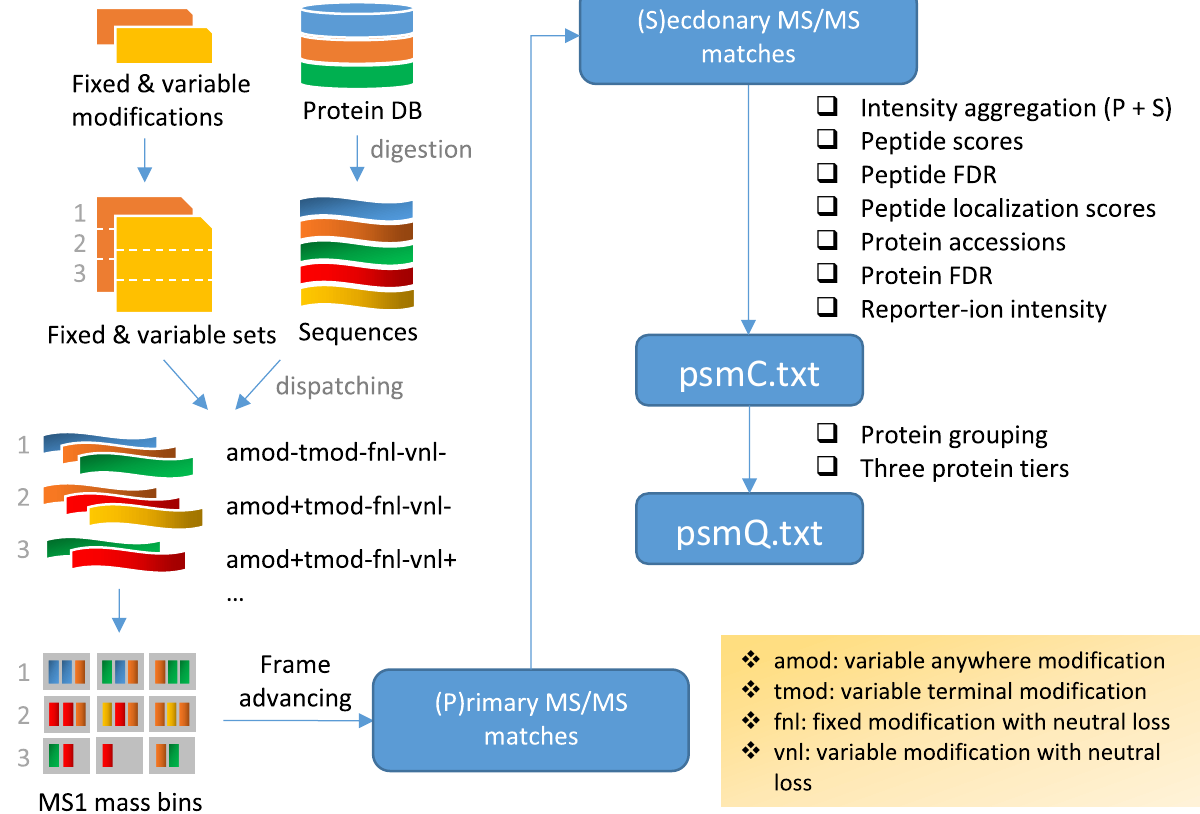
Figure 1. The Mzion workflow. User-supplied fixed and variable modifications are compiled into sets of fixed and variable modifications (Supplementary Note 1). The peptide candidates from in silico digestion are dispatched according to the modification sets (Supplementary Fig. 10). For instance, only sequences with amino-acid residue M will be retained if methionine oxidation is part of the variable modifications in a given set. The sequences are then binned by their precursor masses and searched against experimental MS data. The MS/MS features are first matched by primary product ions, for example, b - and y -ions. The secondary ions, b *, y * (–NH3) etc., are then searched for and the signals are ascribed to the corresponding primary ions. The, and only the, primary ions with the boosted intensity are used in peptide Table 1), the compilation and minimization by Mzion leads to a total of twelve combinations of fixed and vari- able modifications (Supplementary Table 2). It has been observed that an enlarged search space can reduce the numbers of identified PSMs and peptides when controlling false discovery rates (FDR) 19 . The combinatorial minimization by Mzion guards against undue expansion of a search space with regard to users’ intention in finding peptides that are more likely to present in samples. In an example of acetylome (Supplementary Table 3: dataset Lung_A), the numbers of PSMs, peptides (without modifications) and sequences (with applicable modifications) increase by 6.2%, 5.2% and 7.3%, respec- tively, upon the refinement of search space (Supplementary Fig. 1). Analogously in an example of ubiquitylome (dataset Lung_U), the numbers of PSMs, peptides, sequences increase by 3.2%, 4.3% and 5.3%, respectively. Intensity tally from two‑stage searches. A strategy of two-stage search is employed by Mzion. After